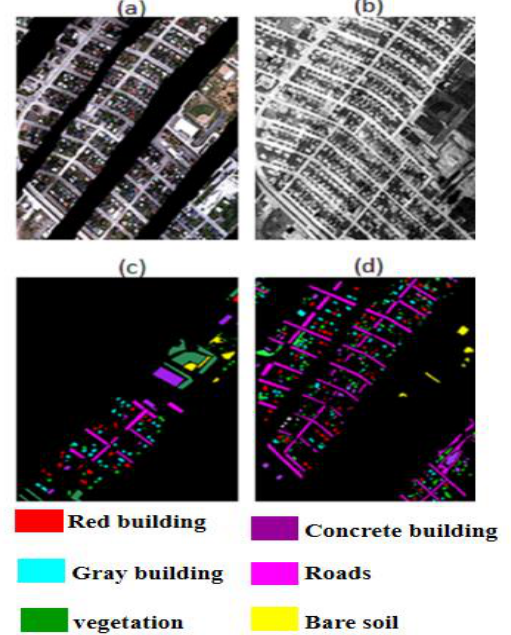
Figure 2. Visible image (a), Thermal data (b), Train data set (c) and Test data set (d)